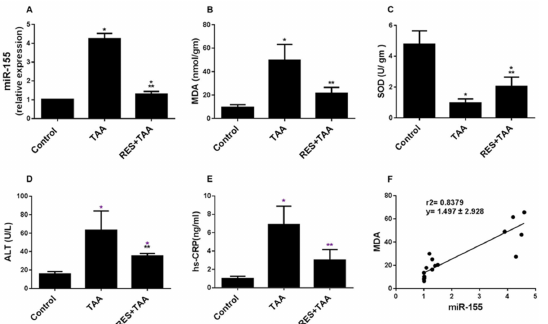
Figure 1. Resveratrol (RES) inhibits miR-155, ROS, and biomarkers of liver injury induced by TAA. Tissue ( A – C ) and blood ( D , E ) levels of miR-155 ( A ), MDA ( B ), SOD ( C ), ALT ( D ), and hs-CRP ( E ) were determined in all rat groups (Control, TAA, and RES + TAA) at week 10. ( F ) Correlation be- tween miR-155 score and MDA. * p ≤ 0.046 versus control, ** p ≤ 0.023 versus TAA. TAA: thioacetam- ide; miR-155: microRNA-155; MDA: malondialdehyde; SOD: superoxide dismutase; ALT: alanine aminotransferase; hs-CRP: high sensitivity C-reactive protein. 3.2. Resveratrol Inhibits TAA-Induced Biomarker of Apoptosis p53 in Liver Tissues In cell signalling, biomarker of apoptosis (p53) is located downstream of ROS [30]. The efficacy of resveratrol to suppress TAA-induced hepatic p53 in rats was investigated. Immunohistochemical analysis of p53 in liver sections of TAA-treated rats revealed a sub- stantial increase in the expression of p53 protein (Figure 2B,D) compared to a weak p53 expression in the control group (Figure 2A), which were significantly ( p < 0.0001) inhibited by resveratrol in the RES + TAA group (Figure 2C,D) to levels still significant ( p = 0.0093) to the control group.